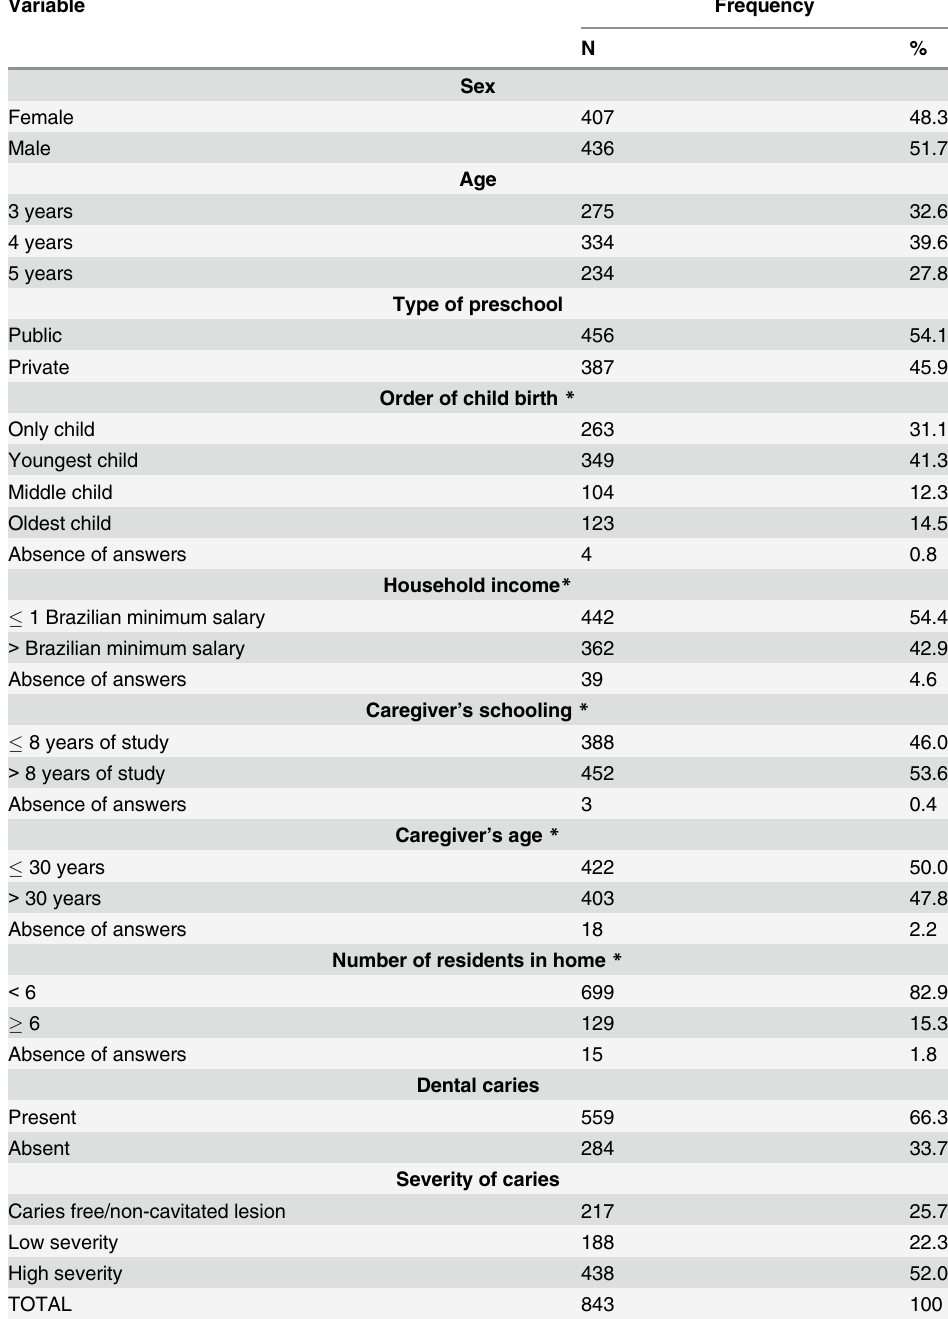
Table 1. Sample characterization and clinical